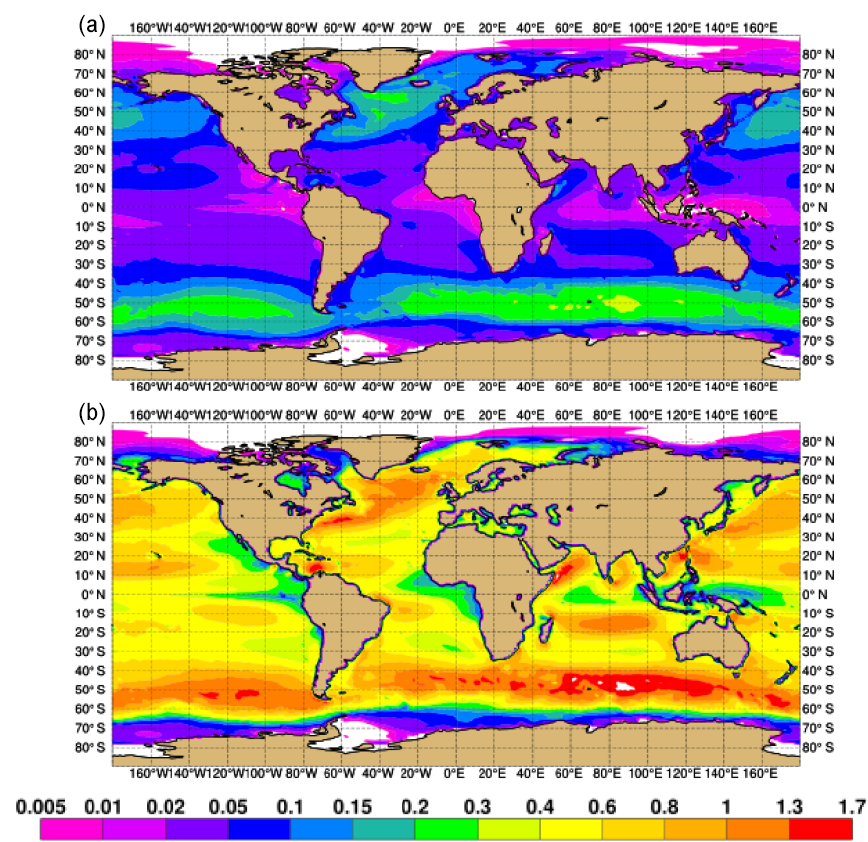
Figure 2. The 2017 total emissions of sea salt aerosol at 80% relative humidity from M86 (a) and G14 (b) (kgm − 2 yr − 1